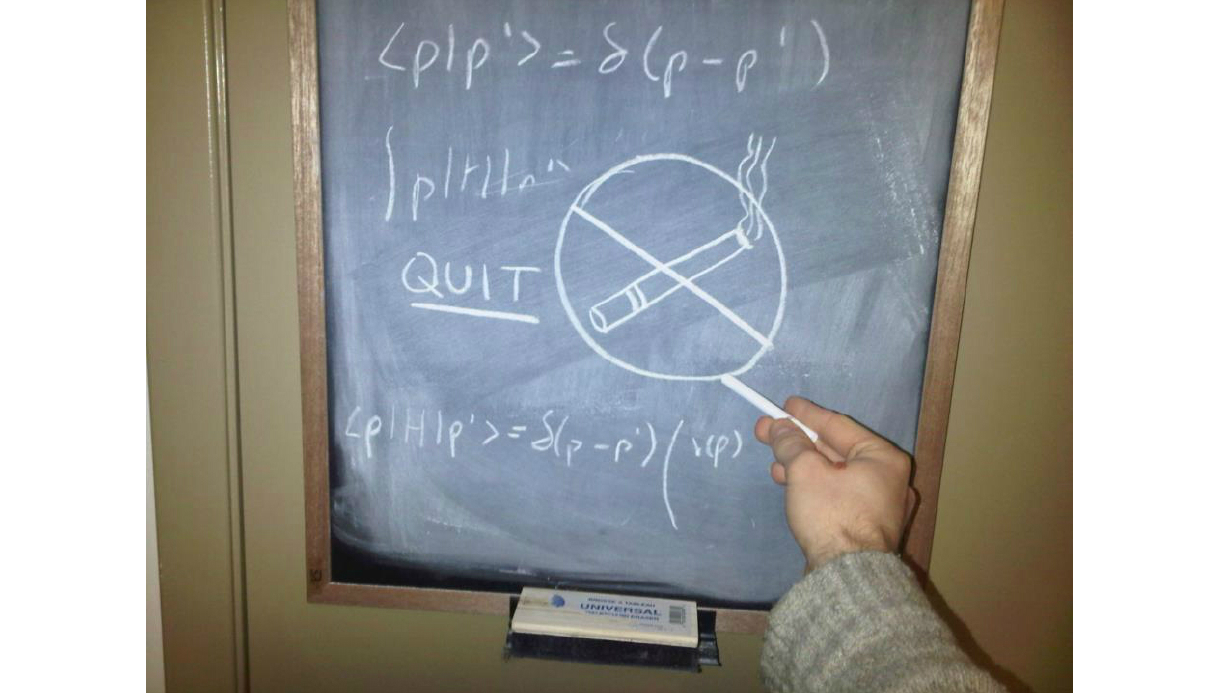
Figure 5. Example of a photo and caption about tobacco use, health, and quitting (Man): “Sometimes smoking gets in the way of my academic pursuits. I take too many breaks, I put off time for studying by adventuring to the local mini mart of gas station, I relax with the subtly deadly nature of tobacco. I feel that if I don’t quit soon, it’ll harm me in the long run, and my pursuit of becoming a professor will die off quit quickly (and literally). As soon as exams are out of the way, I will return to my non-smoking ways. But until then, I must